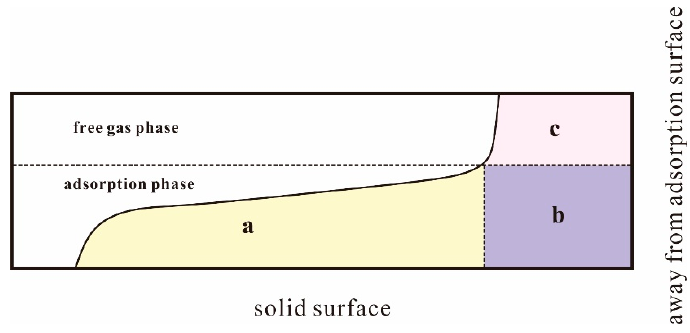
Figure 2. The excess adsorption capacity and the absolute adsorption capacity modified from Zhang et al. [34].